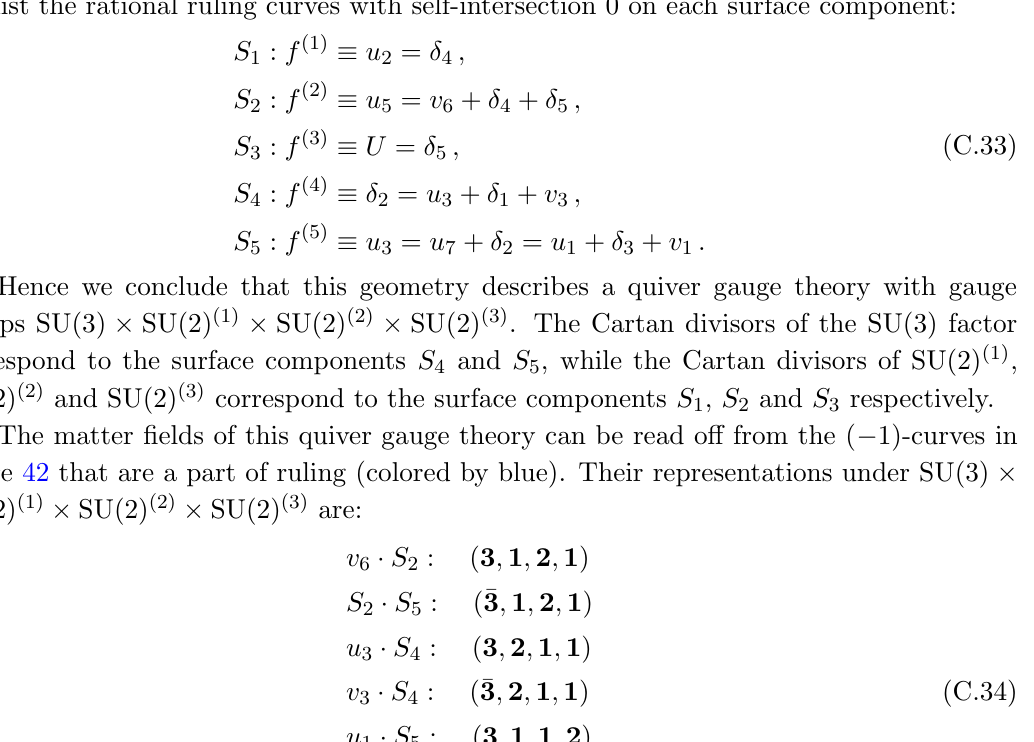
Figure 42. The con(cid:12)guration of curves on S i ( i = 1 ; : : : ; 5) in the resolution geometry BU 2 The number in the bracket denotes the self-intersection number of the curve. The letter denotes an intersection curve with the corresponding divisor. The \/" symbol means that the curves are in the same homology class. The assignment of ruling/section on each surface component is denoted by blue/red